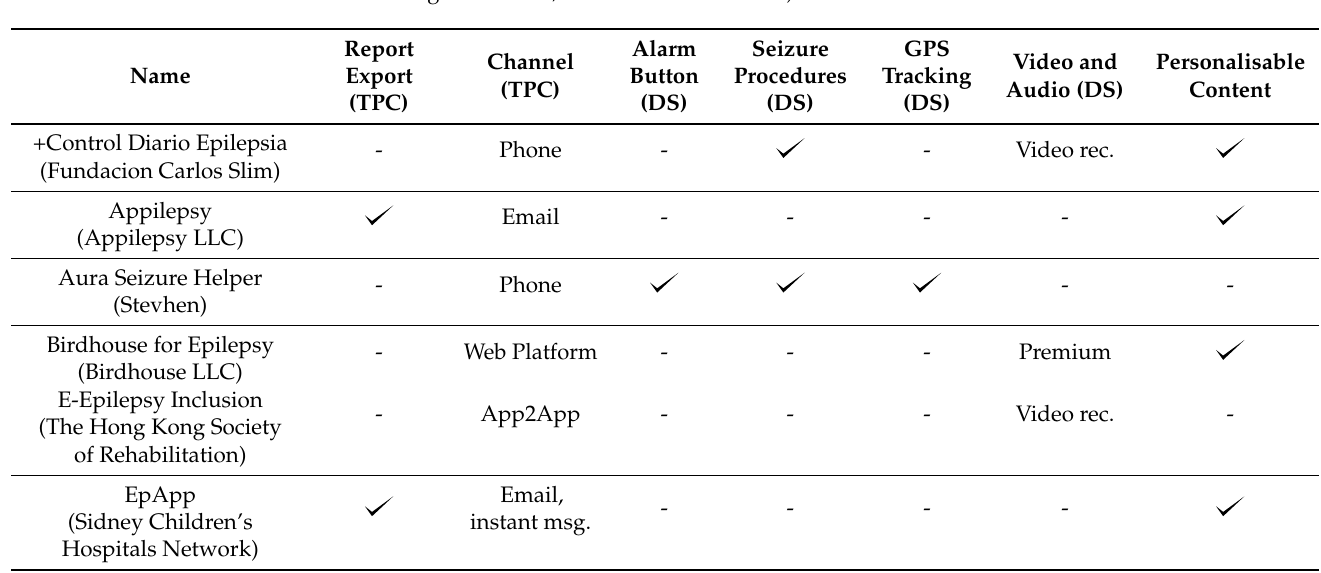
Table A3. In-depth features related to third-party communication (TPC) and available options during seizures (DS). Epilepsy mobile applications for self-management and seizure detection (only remaining candidates, as selected in Table